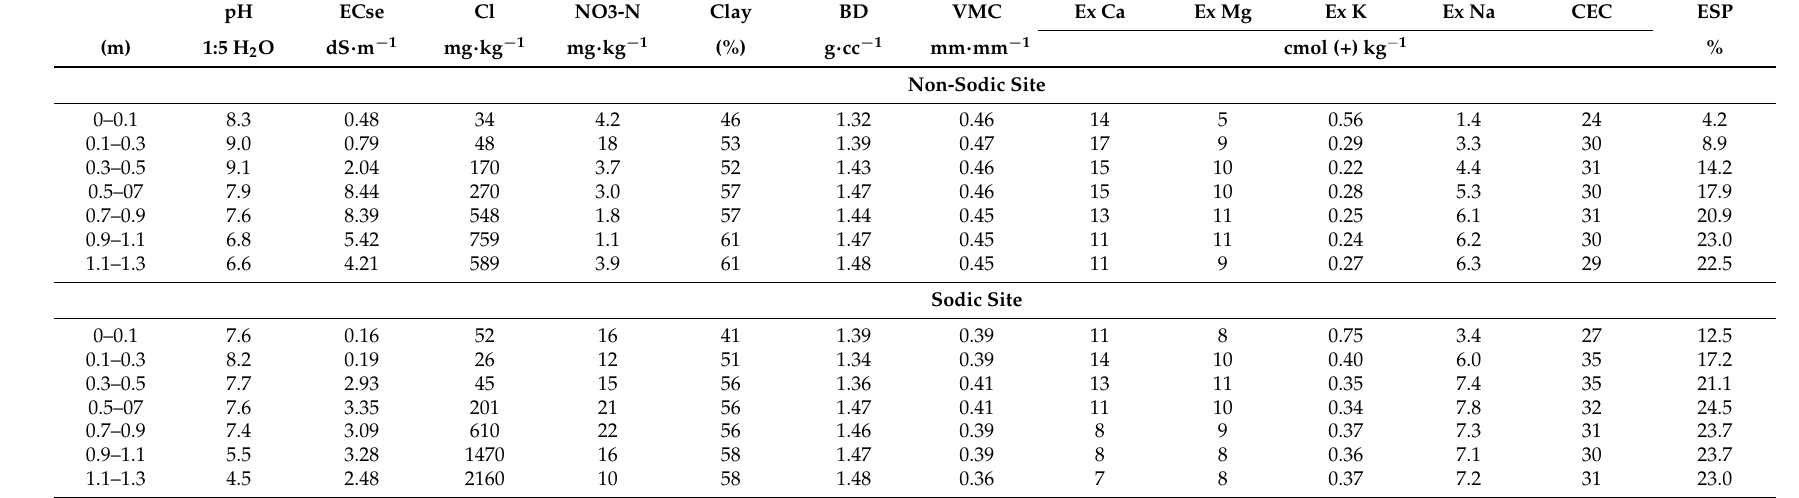
Table 1. Soil pH, electrical conductivity of saturated extracts (EC se ), chloride concentration (Cl − ), nitrogen as NO 3 − , bulk density (BD), volumetric moisture content (VMC), exchangeable cations (Ca ++ , Mg ++ , K + , Na + ) cation exchange capacity (CEC), and sodium percentage (ESP) for a sodic site and a non-sodic site near Goondiwindi in south-east